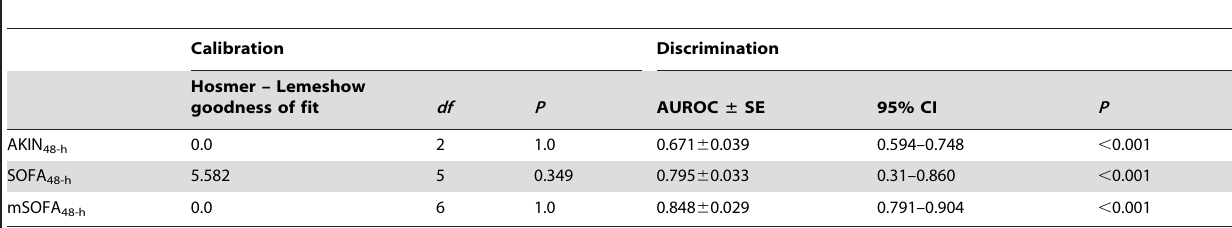
Table 5. Comparison of calibration and discrimination power of AKIN and SOFA scoring methods for predicting mortality (n=187).